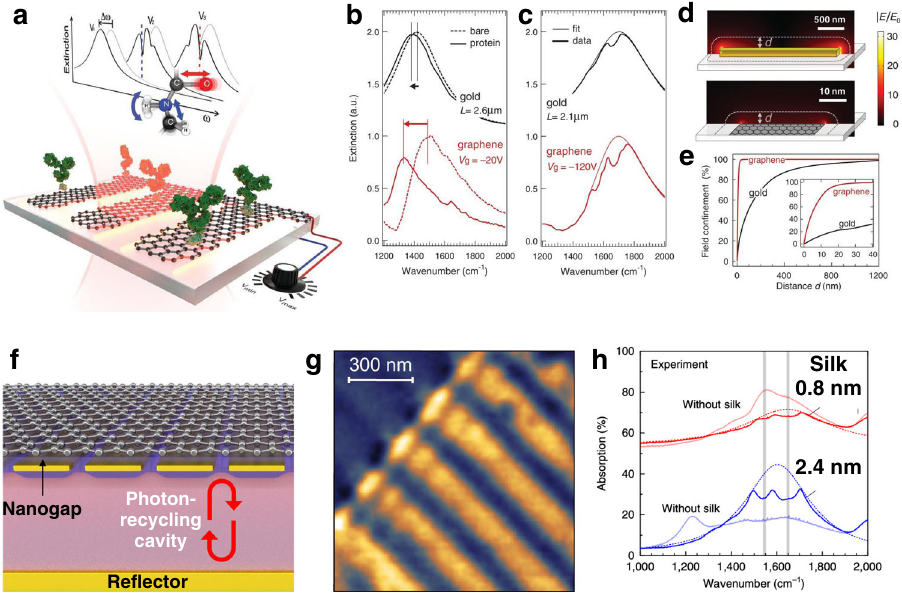
Fig. 4 Graphene-based SEIRA strategies. a – e Graphene-based mid-IR plasmonic biosensing. Adapted from ref. 26 with permission. f Tightly con fi ned graphene acoustic plasmons for sensing a thin layer of protein molecules. Reprinted from ref. 54 with permission. g Near- fi eld of graphene acoustic plasmons propagating along with an array of gold ribbons (bright regions). Adapted from ref. 66 with permission. h Tightly con fi ned graphene acoustic plasmons can detect a thin layer of protein molecules with high sensitivity. Reprinted from ref. 54 with permission.